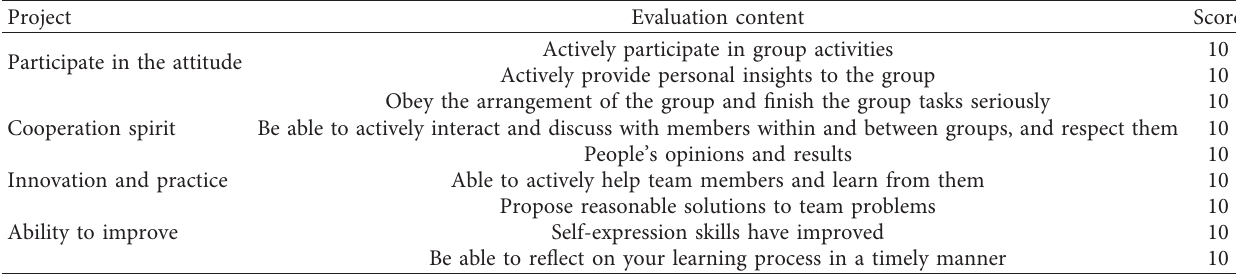
Table 2: Self-evaluation table of cooperative learning.